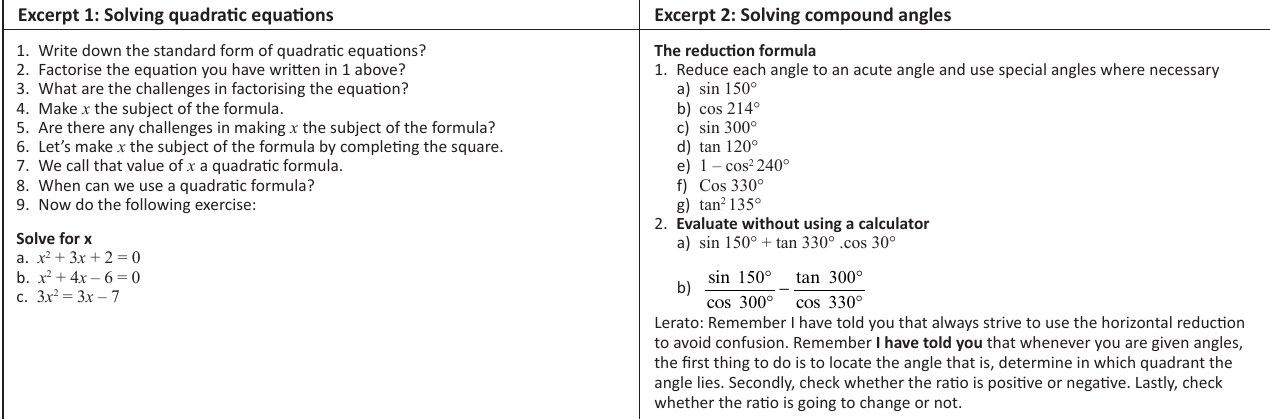
FIGURE 2: Lerato’s two teaching